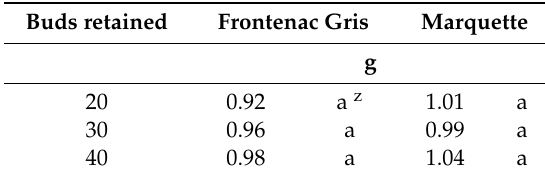
Table 7. Influence of bud retention on berry weight at harvest for two V. riparia -based cultivars averaged over fruit-zone leaf removal levels, locations, and years. Buds